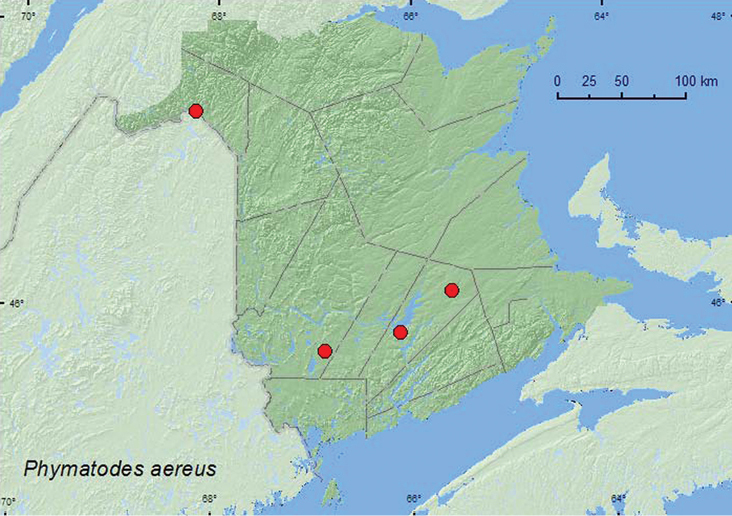
 Collection localities in New Brunswick, Canada of Phymatodes aereus.